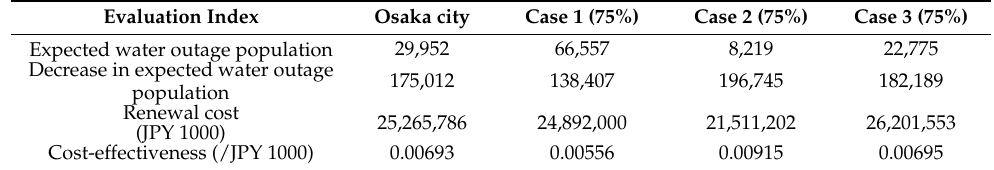
Table 1. Comparison of the current earthquake-resistance plan in Osaka City and the renewal